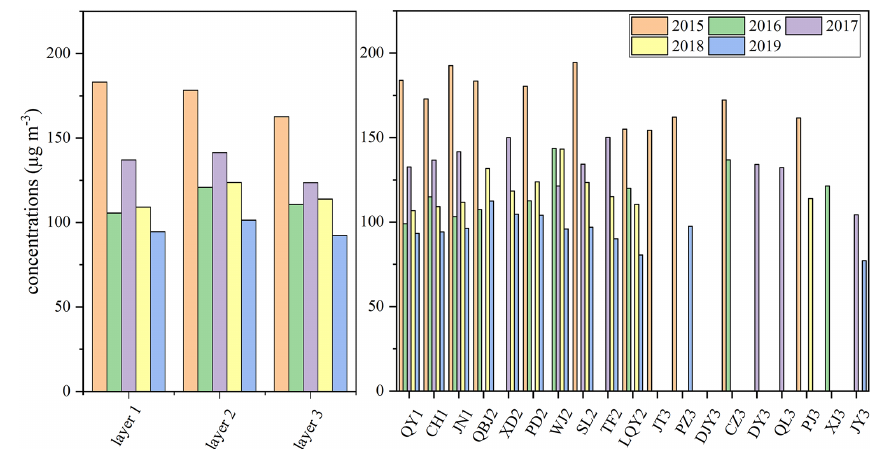
Figure 2. Spatiotemporal variations of PM 2 . 5 concentrations for layers and sampling sites in